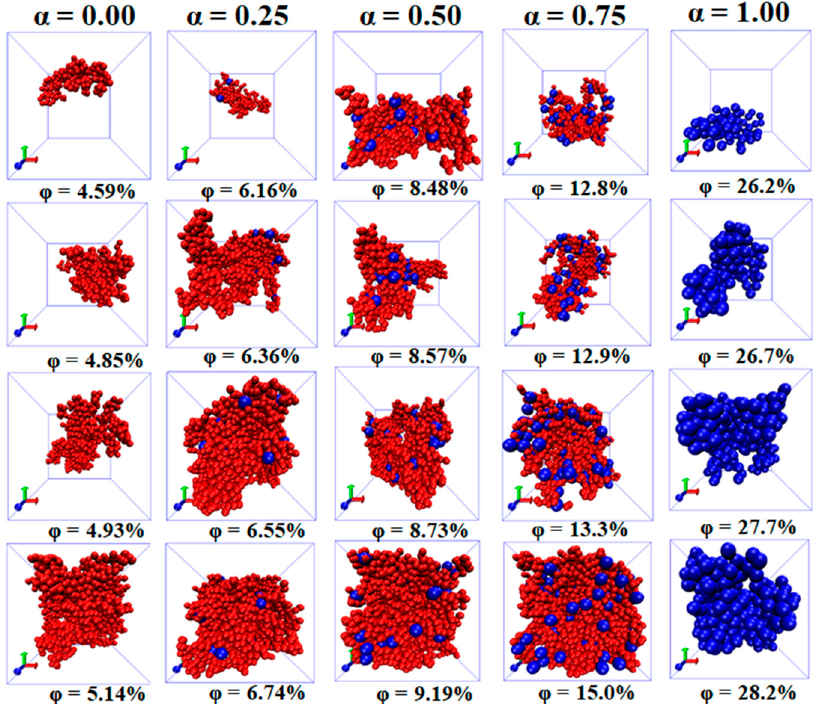
ϕ of nanoparticles (NPs) for dif-